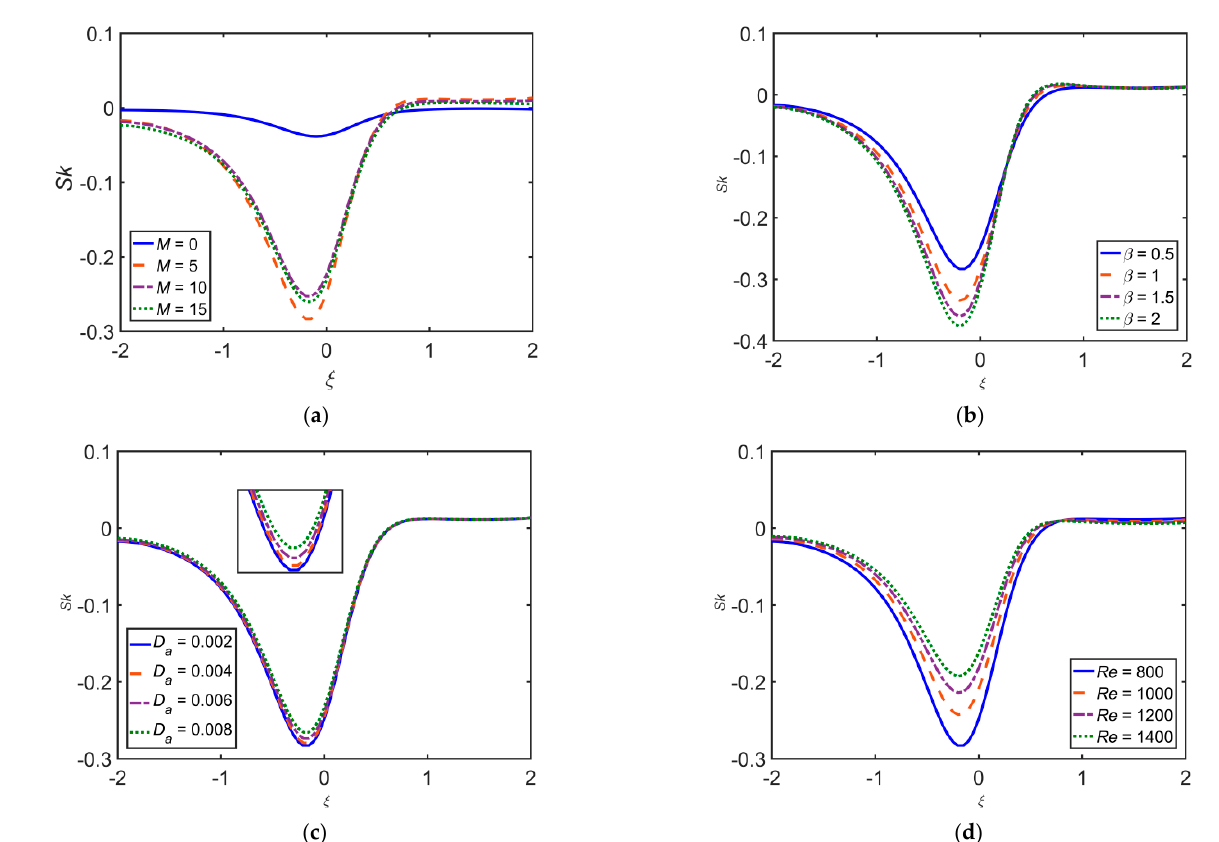
Figure 15. Impact of ( a ) 𝑀 , ( b ) 𝛽 , ( c ) 𝐷 (cid:3028) , ( d ) 𝑃𝑒ℎ , ( e ) 𝑅𝑑 , ( f ) 𝑆𝑟 , ( g ) 𝑃𝑒𝑚 , and ( h ) 𝑅𝑒 on 𝑆ℎ . Figure 16 depicts the effect of various flow governing parameters on skin friction coefficient 𝑆𝑘 . The 𝑆𝑘 has a direct relation with 𝐷 (cid:3028) and 𝑅𝑒 , whereas it has an inverse relation with 𝑀 and 𝛽 .